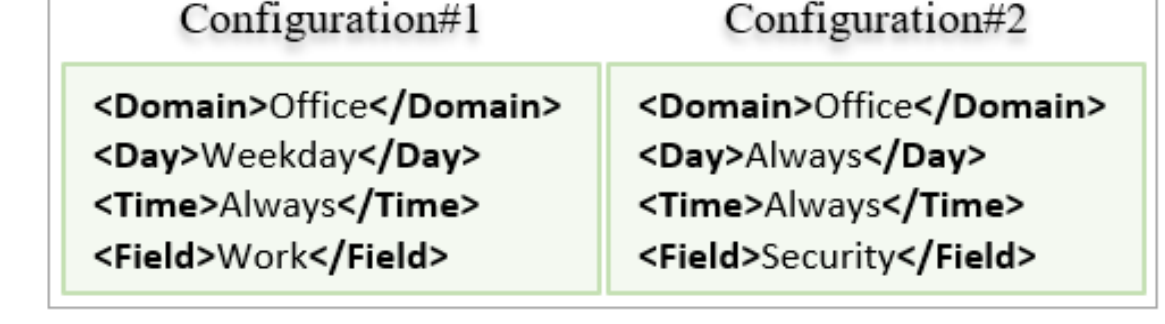
Figure 11. Explicit preferences for the third scenario.